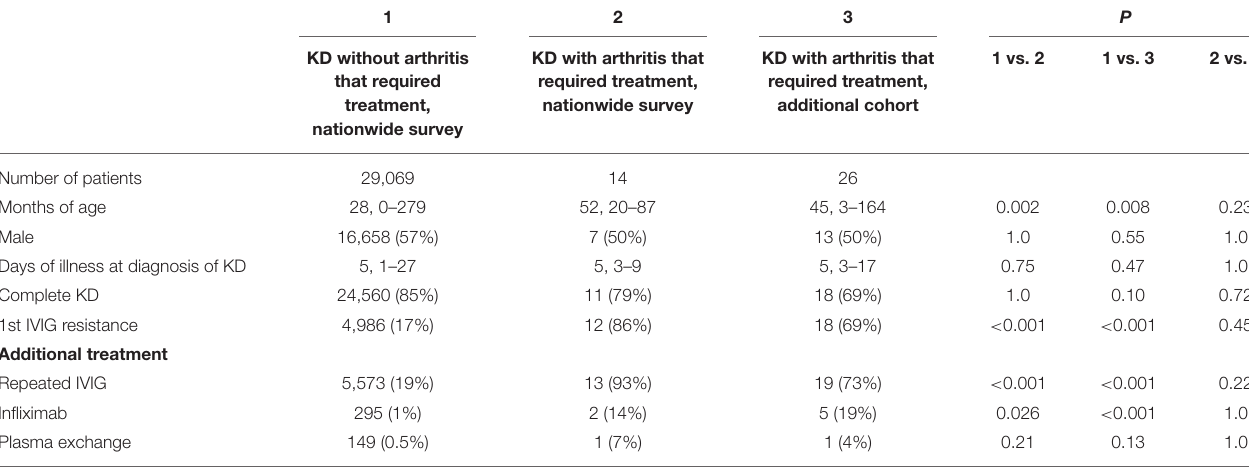
TABLE 1 | Demographic characteristics of KD patients with and without arthritis that required treatment.